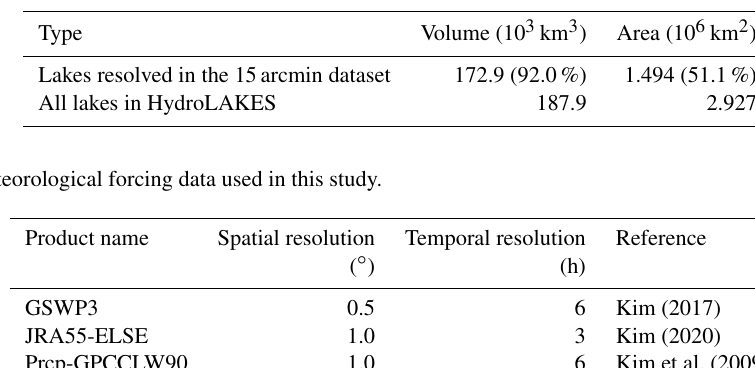
Table 3. Summary of the lakes resolved in the dataset and all of the lakes in HydroLAKES. (Values in the parentheses indicate the fraction of the resolved lakes to all of the lakes.)